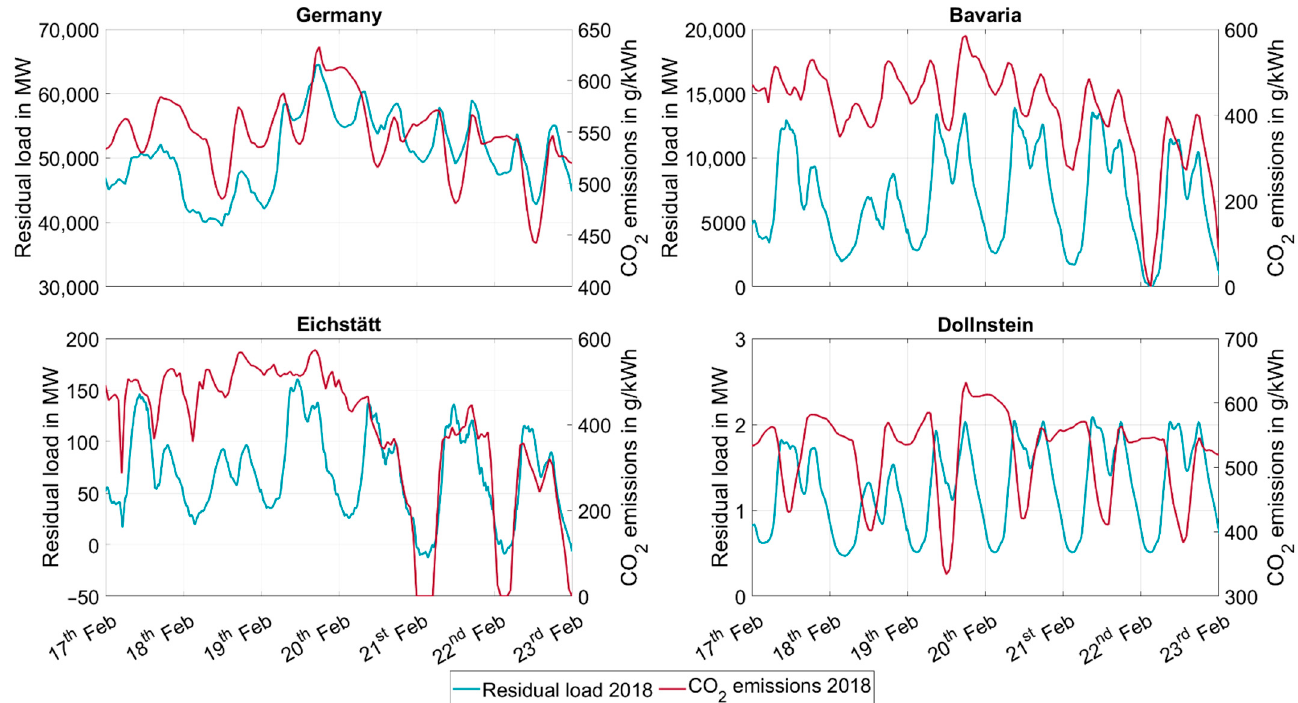
Figure 3. Comparison of the behavior of the residual load curves and the CO2 emissions of the electricity mix in each region for Germany , Bavaria , Eichstätt , and Dollnstein from the 17th of February until the 22nd of February 2018.